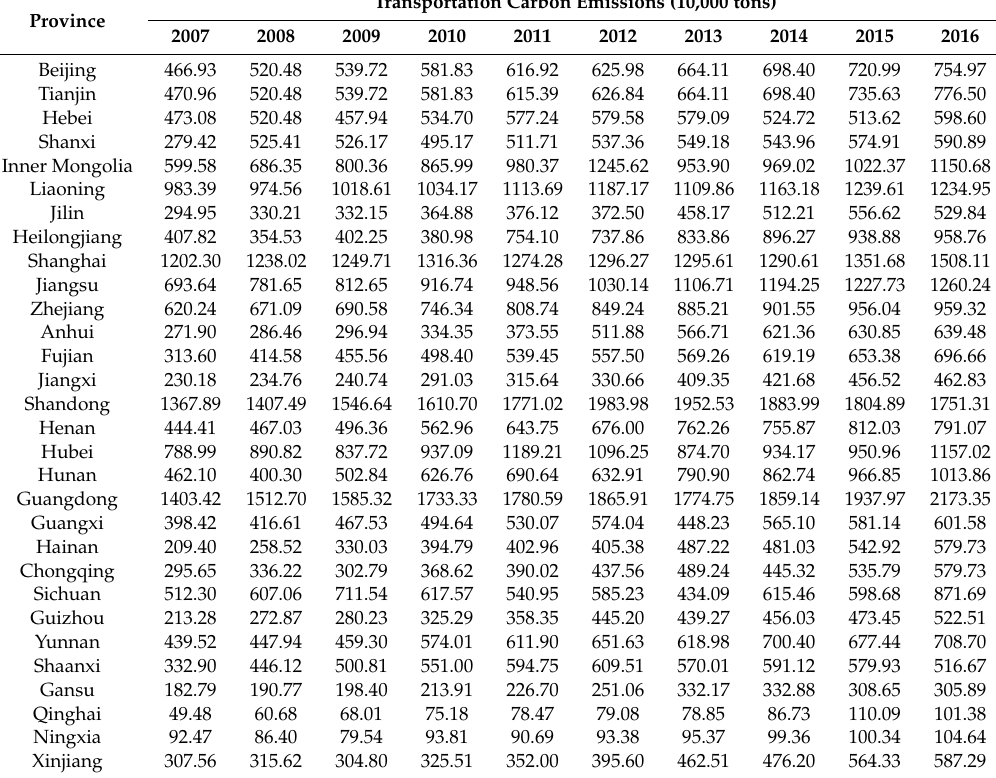
Table 2. Energy calculation coefficient.